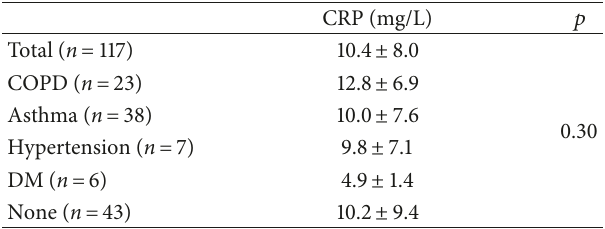
Table 5: Comorbid conditions, which may have an effect on systemic inflammation and the CRP